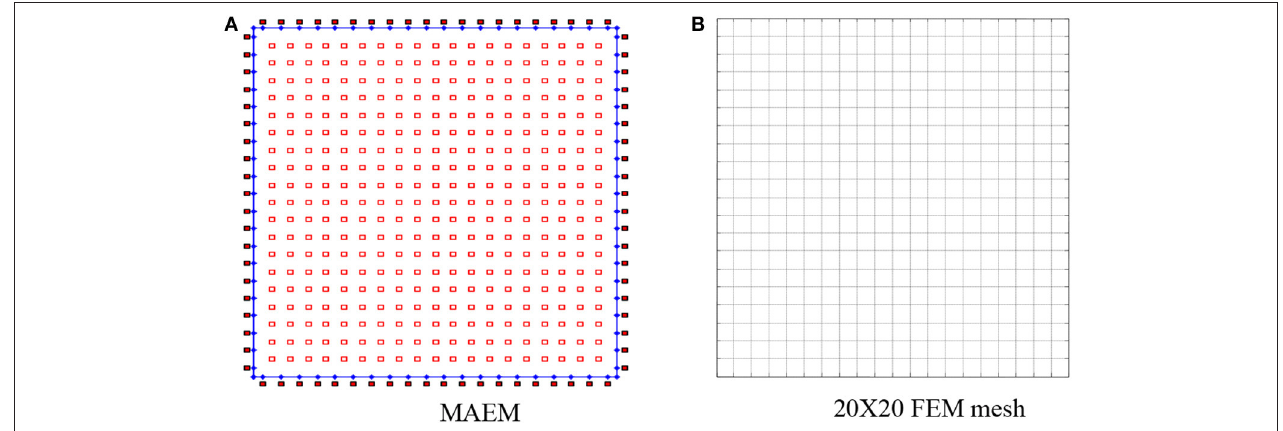
FIGURE 4 | (A) Shell collocation scheme MAEM. (B) Shell discretization FEM.